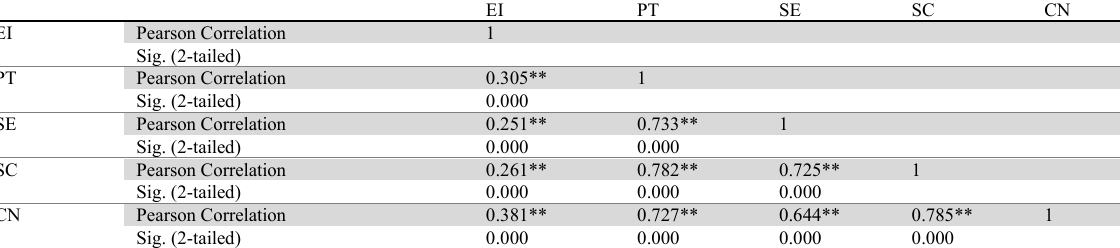
Fig 3. Respondents’ activities related to entrepreneurial behaviours during their studies Correlation coefficients between variables